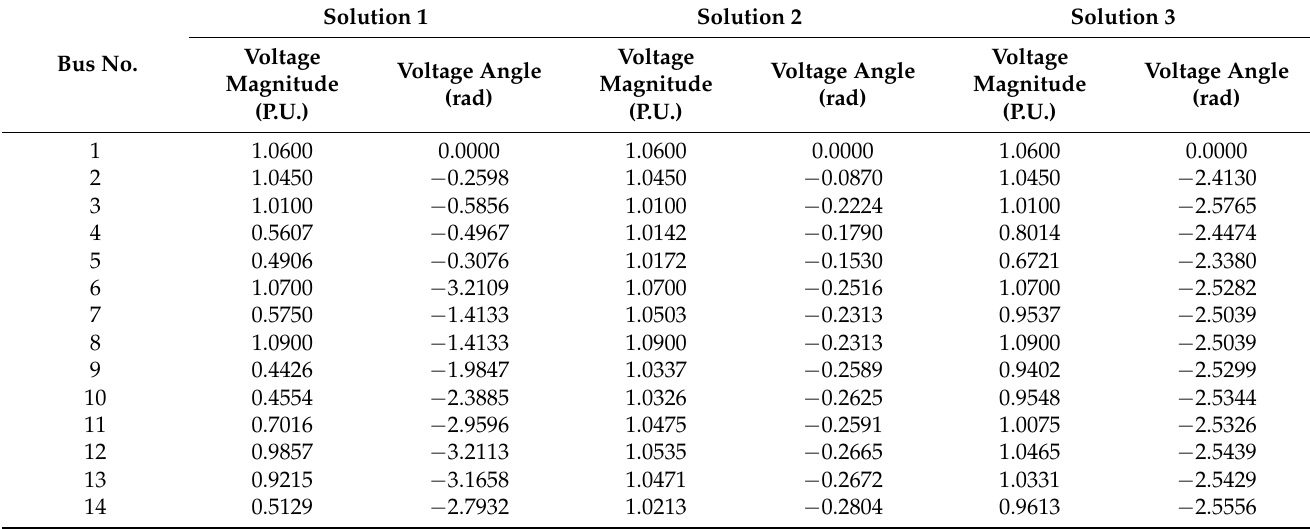
Table 7. Multiple Load flow solutions for IEEE 14-bus system under normal conditions.